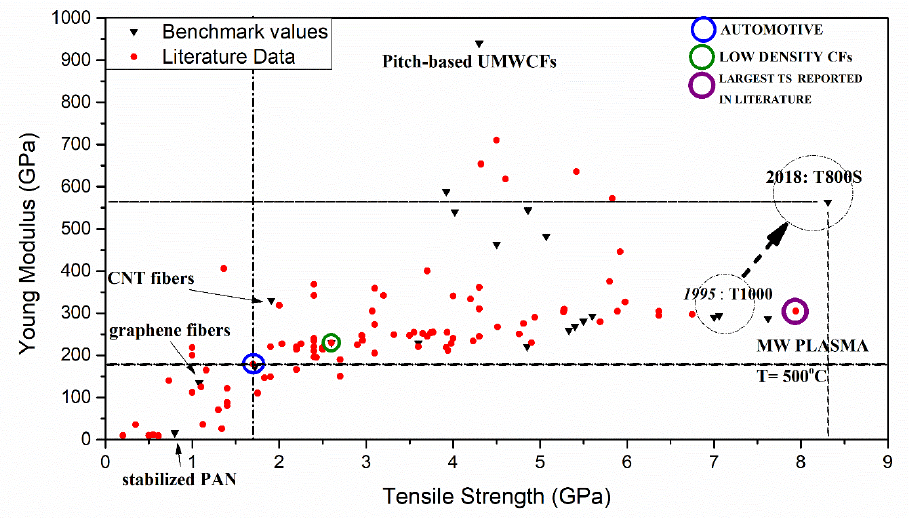
Figure 3. Young Modulus vs. Tensile Strength: Benchmark values and literature data are reported [1,2,5,8,10–13,16,19,20,24,29,32,39–41,64,75,98,116,118–129].